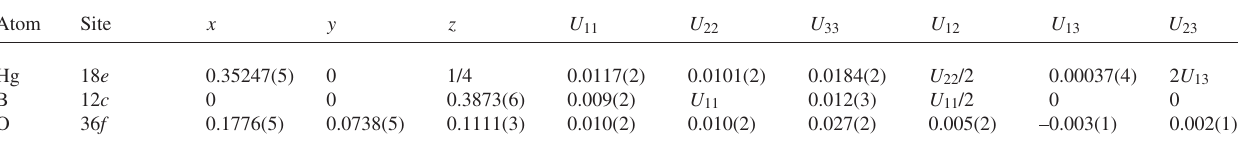
Table 2. Atomic coordinates and displacement parameters (in Å 2 ) .